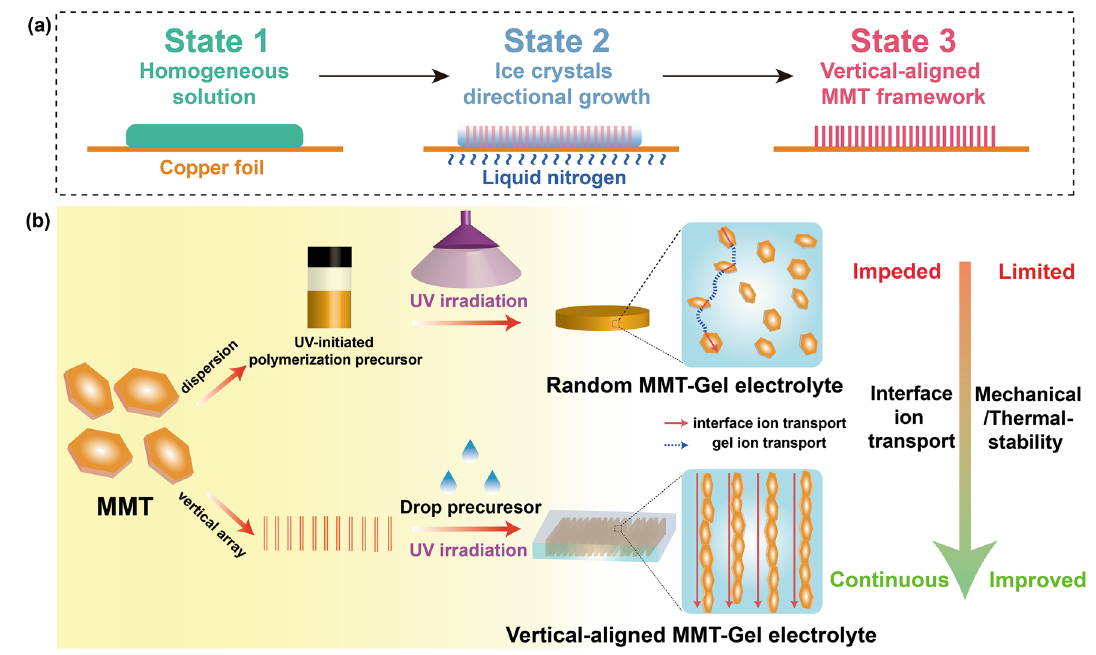
Fig. 1 Synthesis of vertical-aligned MMT and composite GPEs with random MMT or VAMMT. a Schematic illustrating of VAMMT prepared by directional freezing technology. b Schematic of the fabrication process of different